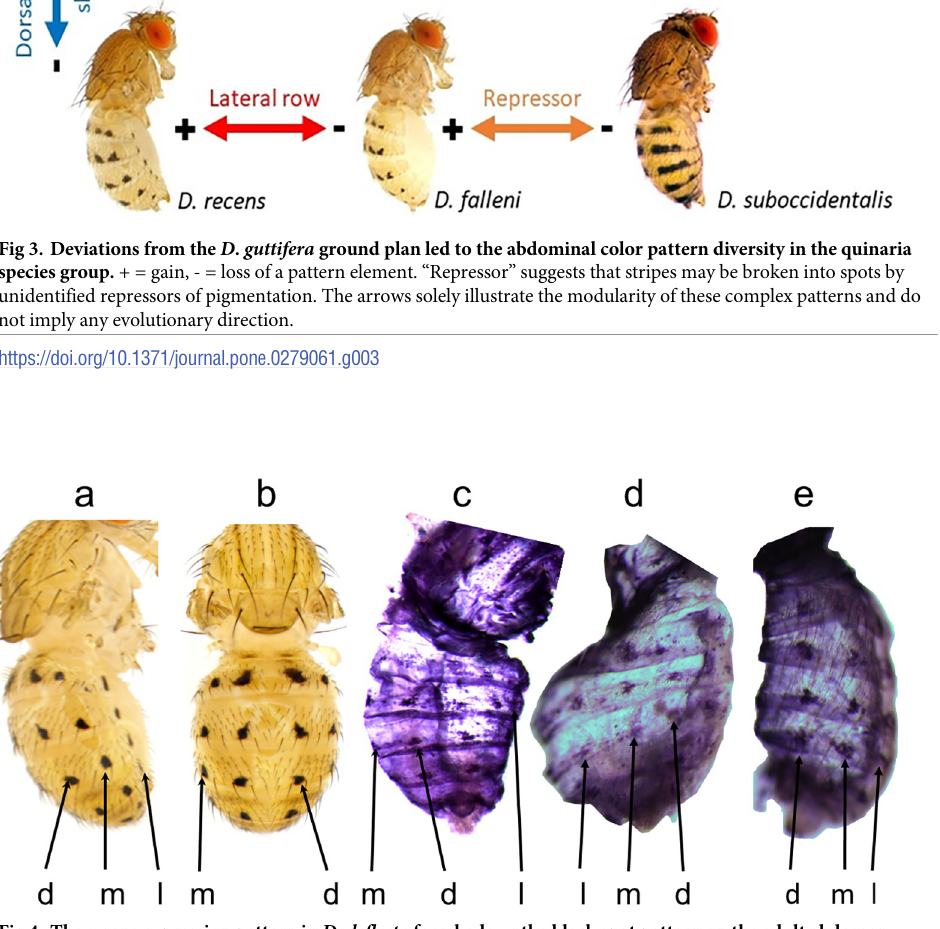
Fig 4. The y gene expression pattern in D . deflecta foreshadows the black spot pattern on the adult abdomen. a, Adult lateral view. b, Adult dorsal view. c-e, y mRNA in the P10 pupal epidermis prefigures the adult spot pattern. d = dorsal, m = median, l =